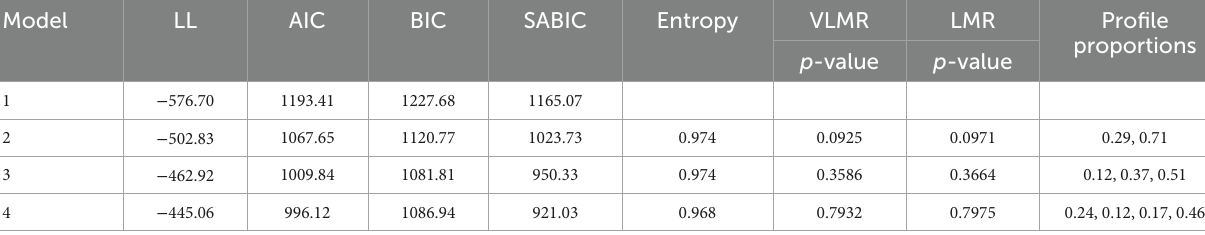
TABLE 2 Latent profile analysis (LPA) model fit summary and profile